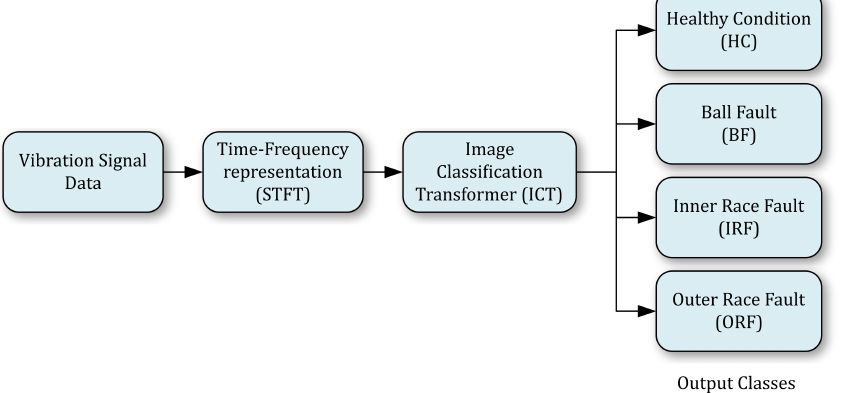
Figure 3. Block diagram of the proposed fault diagnosis system.